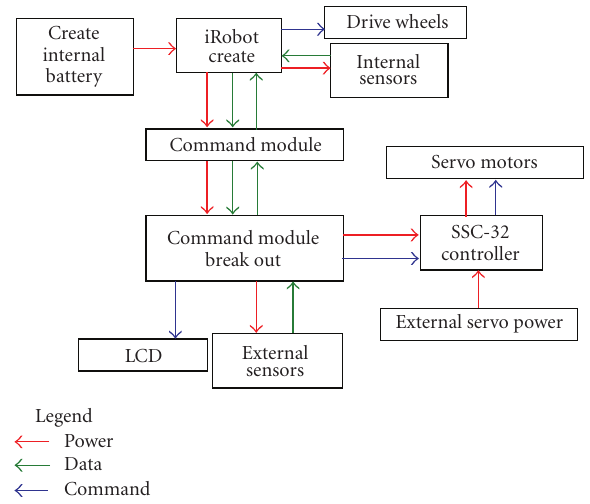
Figure 11: The robotic electrical systems overview.